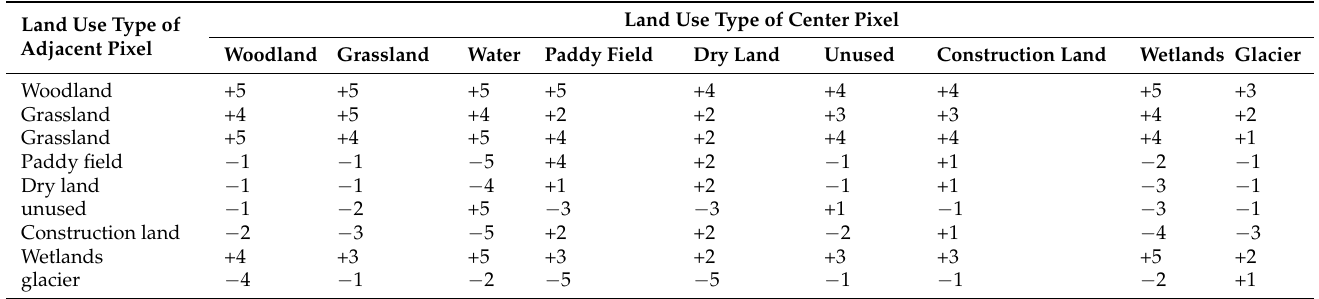
Table 3. Spatial proximity effect coefficients of ecosystem services for each land use